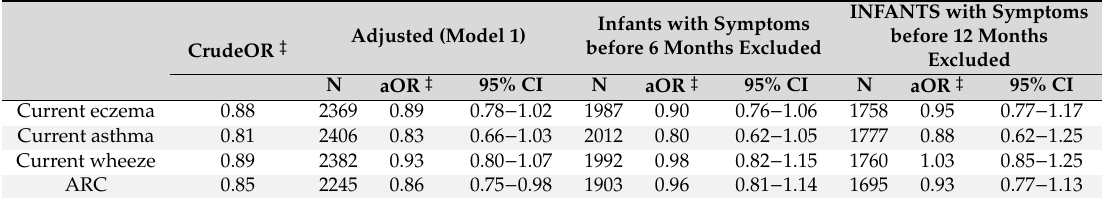
Table 4. Association between the age of introduction of fish and allergic disease at six years.